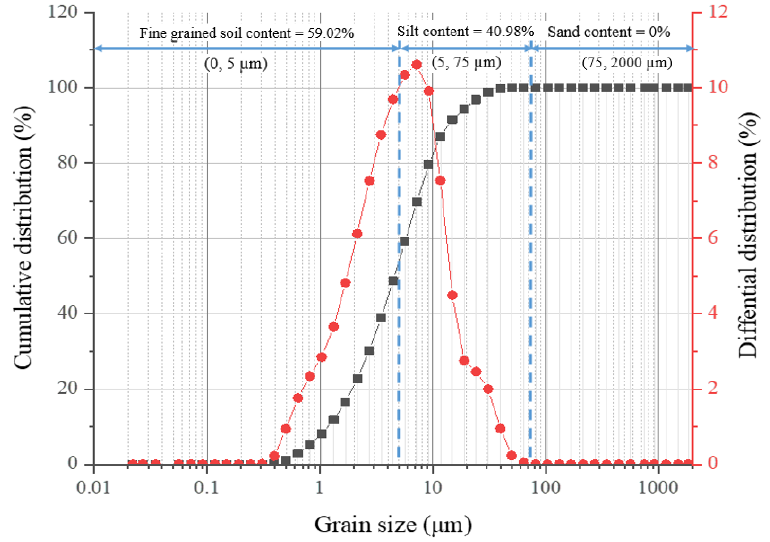
Figure 2. Particle distribution curve of test soil.